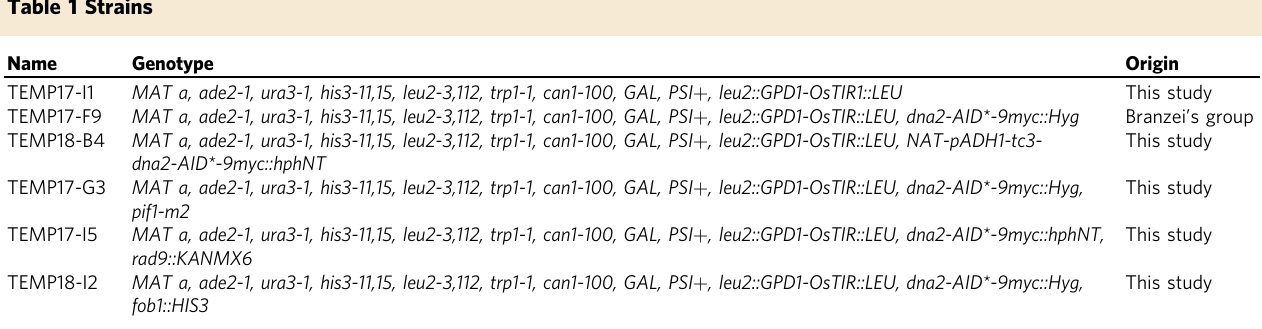
D-loop structure, which initiates DNA replication through BIR 65 .